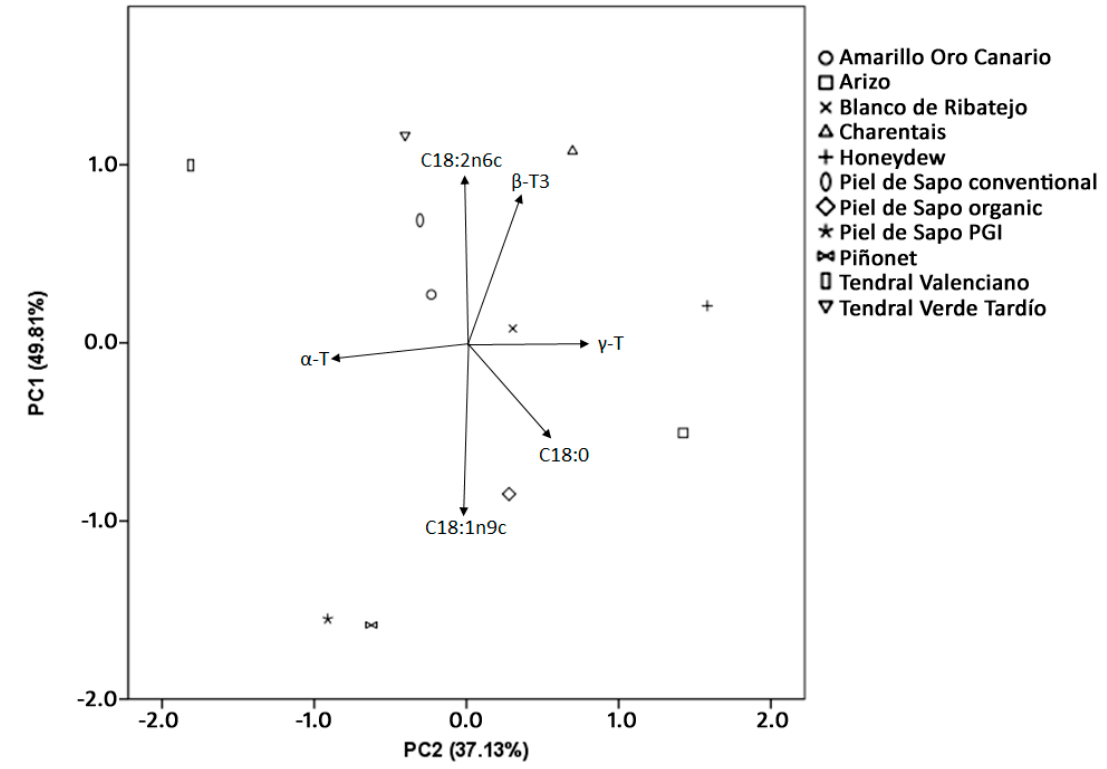
Figure 1. Principal-component analysis of oils from selected melon-seed cultivars.